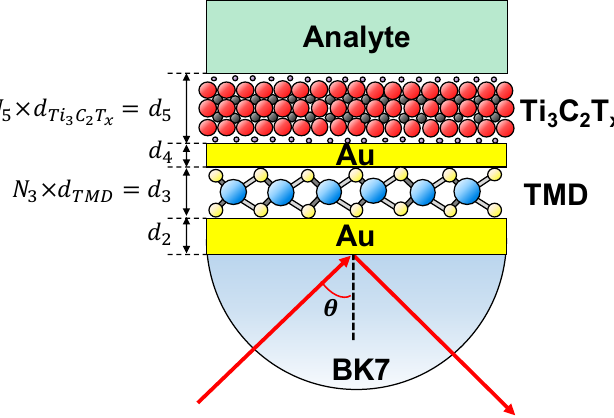
Figure 1. Schematic illustration of the proposed surface plasmon resonance (SPR) sensor with Ti 3 C 2 T x and 2D transition metal dichalcogenides (TMD)